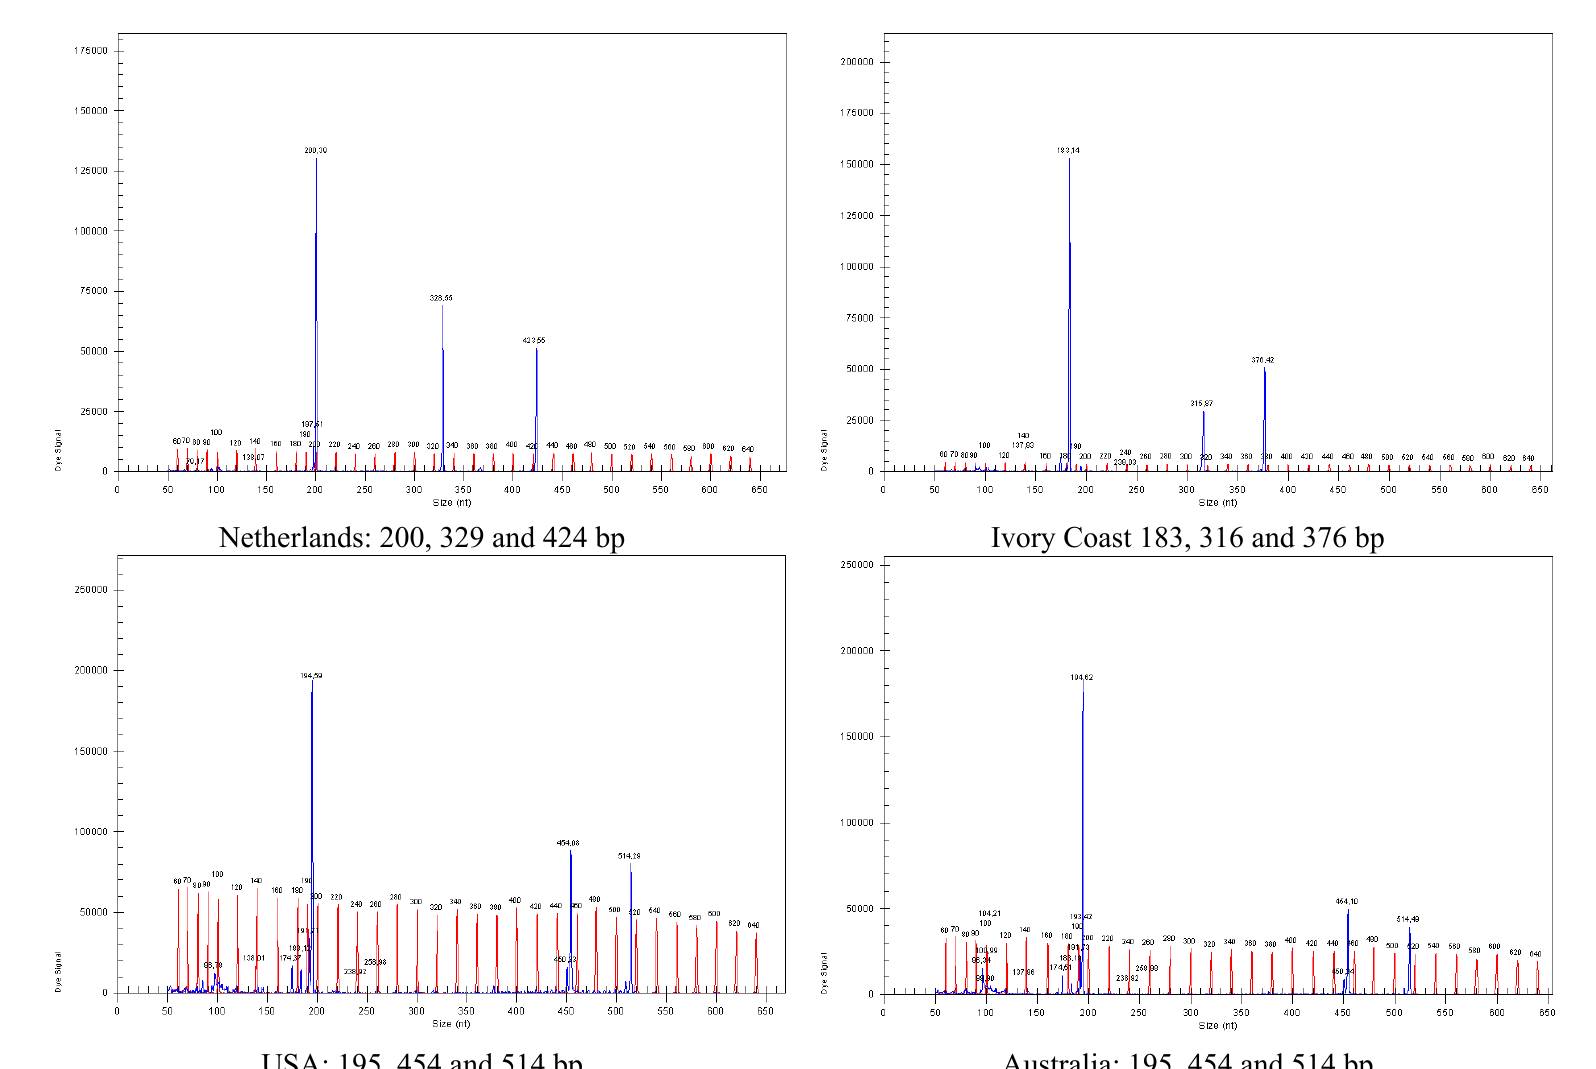
Figure 3. Capillary gel electrophoresis from multiplex PCR with Cy5 labeled forward primers. Blue: fluorescence signals from SSR fragments, red: DNA length standard 20 bp ladder. Representative examples are shown for the isolates from The Netherlands, Ivory Coast, USA and